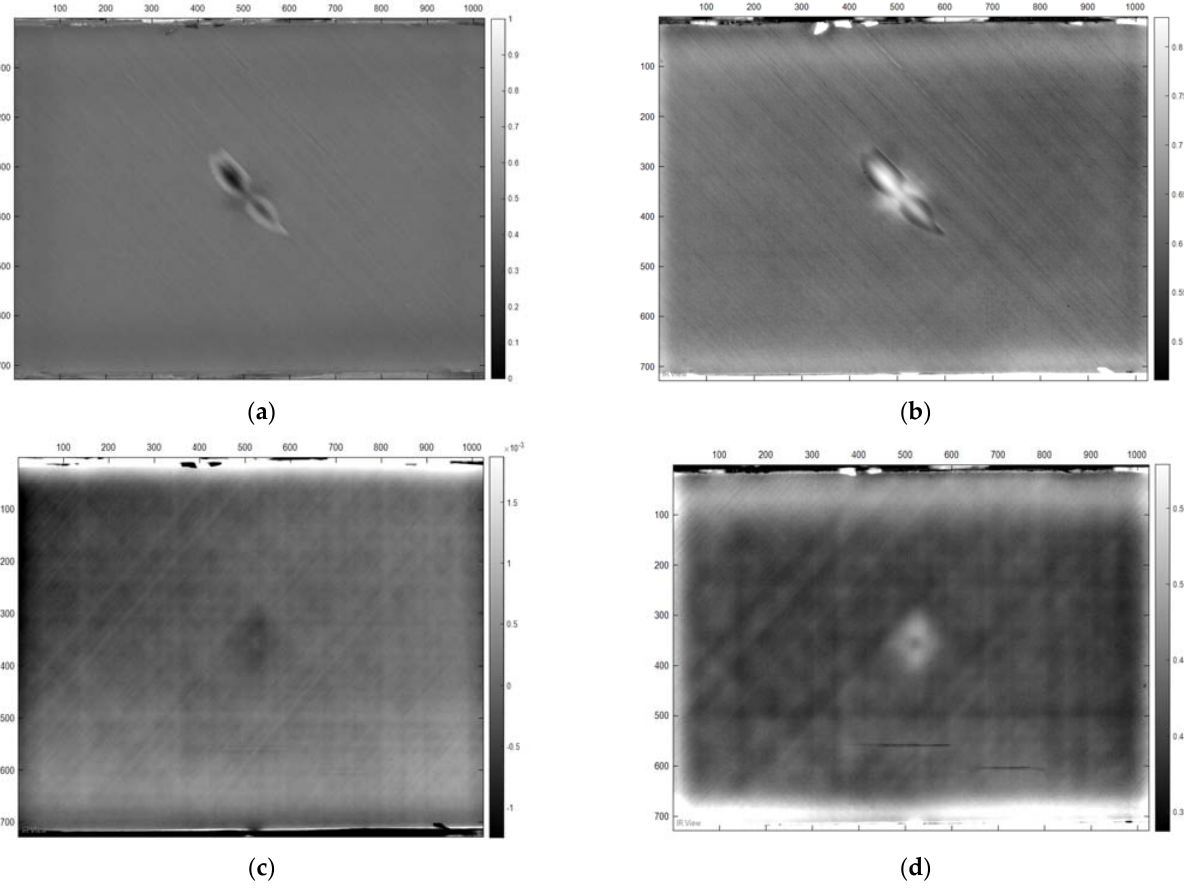
Figure 11. Image Processing Results. ( a ) reflection mood. ( b ) reflection mode. ( c ) transmission mode. ( d ) transmission mode.